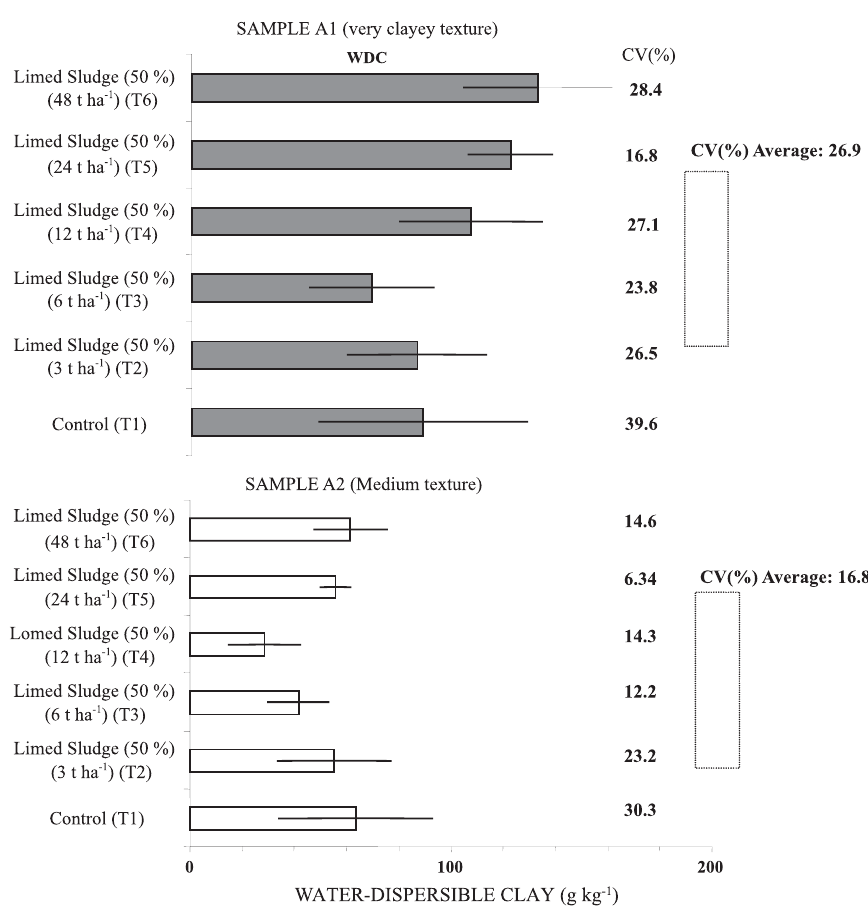
Figure 1. Average values for water-dispersible clay (WDC), coefficient of variation (CV %) and confidence interval, CI (95 %) for very clayey soil (A1) and medium texture soil (A2), after 180 days of incubation in pots kept in a